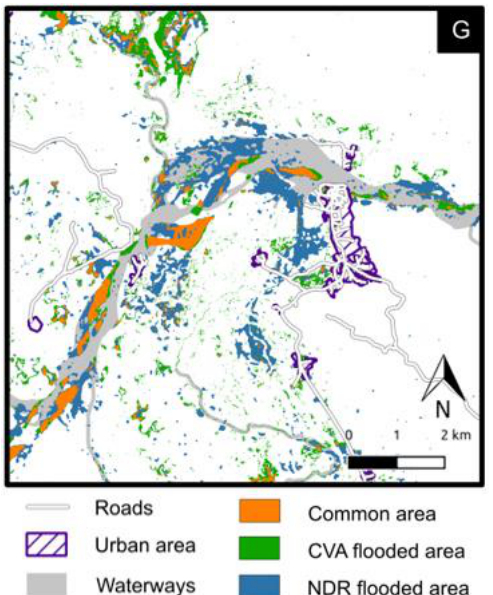
Figure 5. Comparison between Sentinel-2 CVA, Sentinel- 1 NDR and Copernicus products ( © OSM contributors